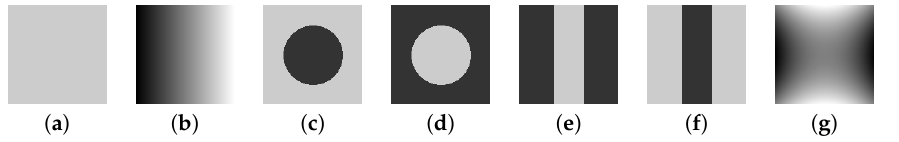
Figure 12. The seven archetypal image patches of the BIF: flat area ( a ), gradient ( b ), dark spot ( c ), bright spot ( d ), bright edge ( e ), dark edge ( f ) and saddle ( g